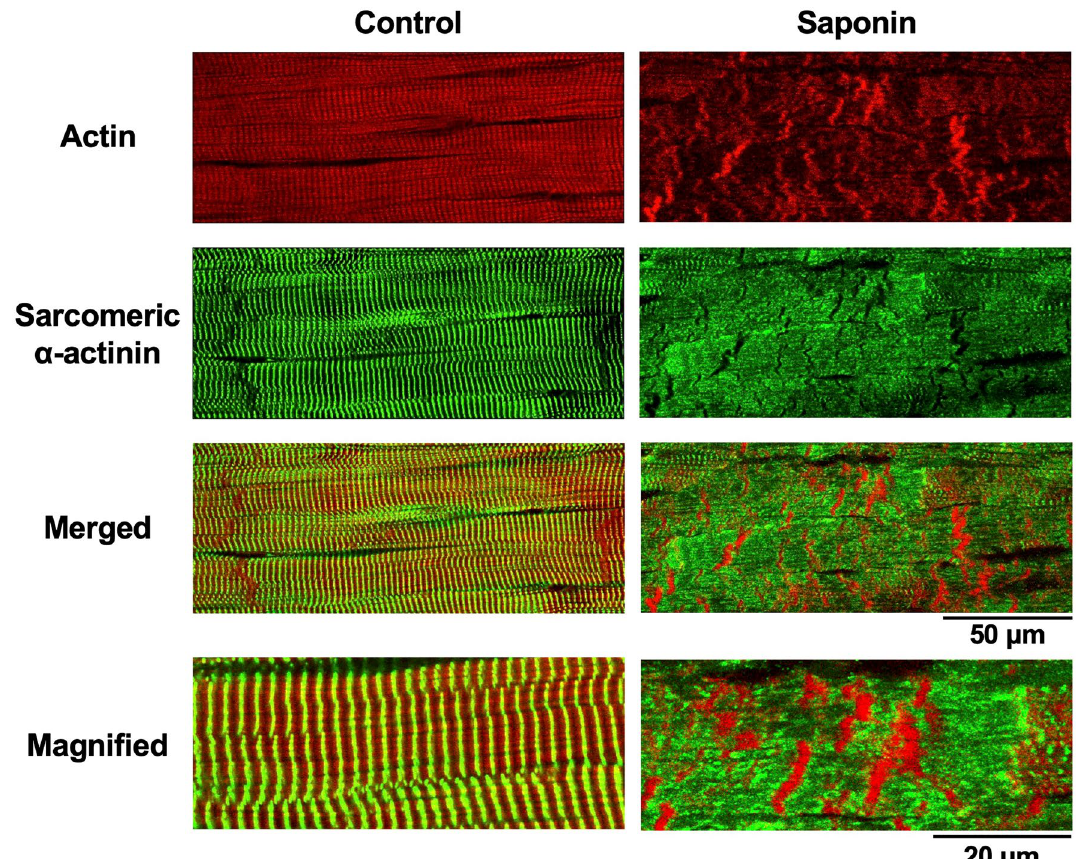
Figure 3. Contraction-band formation in saponin-treated myocardial samples as revealed by confocal fluorescence imaging of actin and α-actinin. Images present the high-affinity actin probe phalloidin ( red ), sarcomeric α-actinin immunohistochemistry ( green ), and merged images in the absence ( left ) and presence of saponin ( right ). Magnified images of the merged evaluations are shown on the bottom. Note that saponin induces contraction-band formation, increasing actin aggregation and disrupting